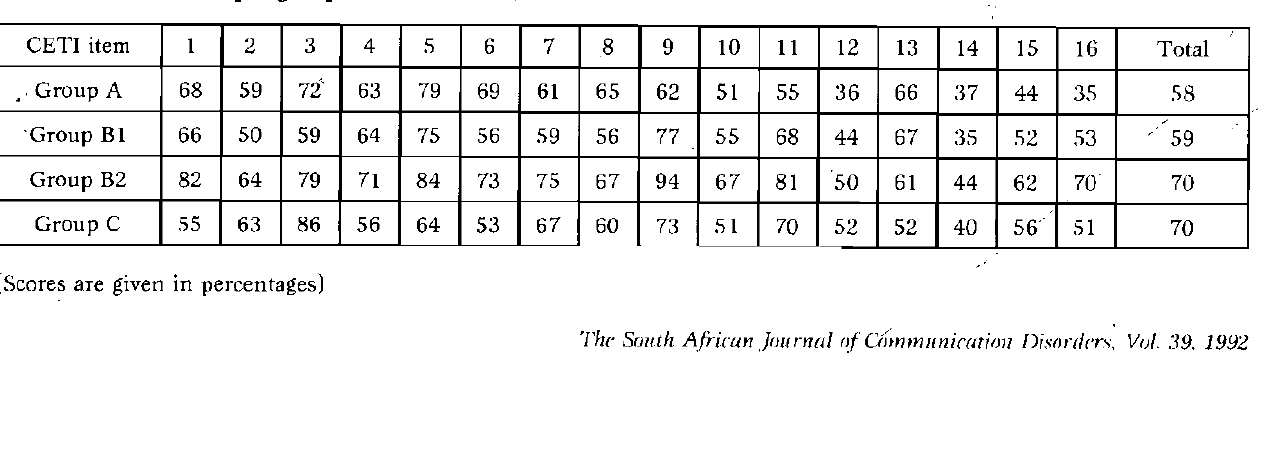
Table 2: Mean scores per group across CETI items CETI